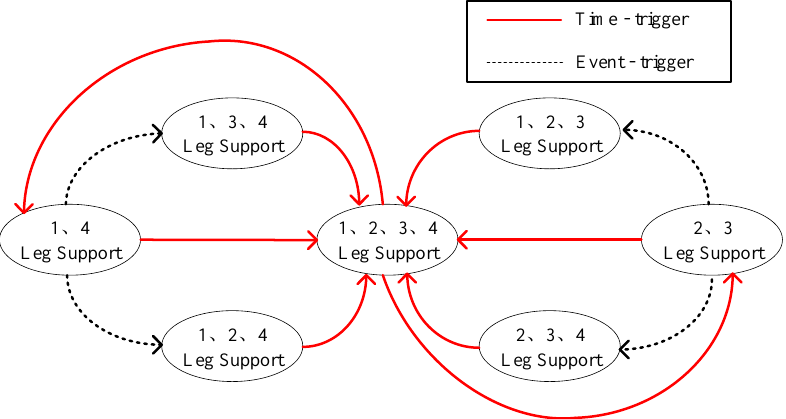
Figure 4. Time-triggered hybrid trigger. The numbers are manually calibrated to facilitate the description of relative positional relationships, Details are in Figure 3.